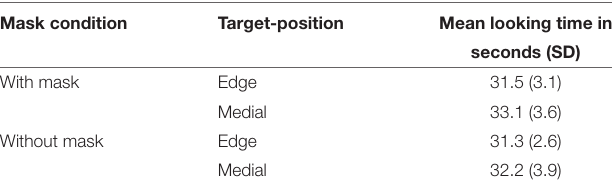
TABLE 2 | Mean-looking times for the familiarization phase in the auditory